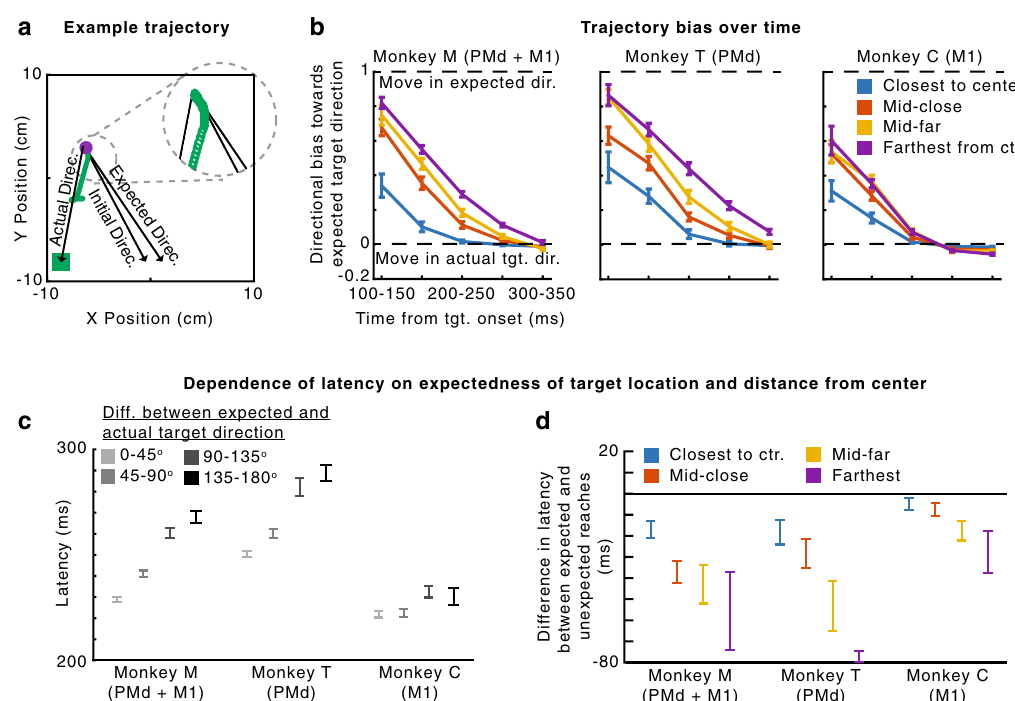
Fig. 2 Behavior. a An example trajectory. The initial direction of the reach (green) starts toward the expected direction of the target, given the current hand position. It later moves in the actual direction of the target. The inset shows an enlarged view of the beginning of the reach. b The median bias of the trajectory over time. A bias of 1 signi fi es that the direction of the trajectory is toward the expected target direction, while a bias of 0 signi fi es that the direction of the trajectory is toward the actual target direction. Negative biases signify movement away from the expected direction. Different traces are shown for hand positions at varying distances from the center of the workspace. Error bars are standard errors of the median. c The mean latency of reaches as a function of the angular difference between the actual and expected target directions. d The difference in mean latency between expected and unexpected reaches (expected minus unexpected), depending on the hand ’ s distance from the center. “ Expected ” reaches are those that had an angular difference between the actual and expected target directions of less than 60°. “ Unexpected ” reaches had an angular difference of more than 120°. In panels c and d , error bars represent SEMs. In panels b and d , distances from the center are divided as follows: “ closest ” is 0 – 20% of distances from the center, “ mid-close ” is 20 – 40%, “ mid-far ” is 40 – 60%, and “ farthest ” is 60 – 100%. We used these divisions for plotting, rather than standard quartiles, to ensure that there were “ unexpected ” reaches in each bin. When using standard quartiles, there were no “ unexpected ” reaches for some monkeys in the last quartile (greatest 25% of distances from the center) because when very far from the center, the next target cannot be in an unexpected direction (farther away from the